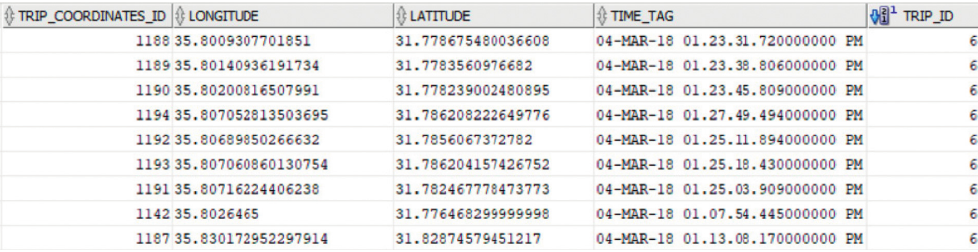
Figure 11: The trip coordinates database table.